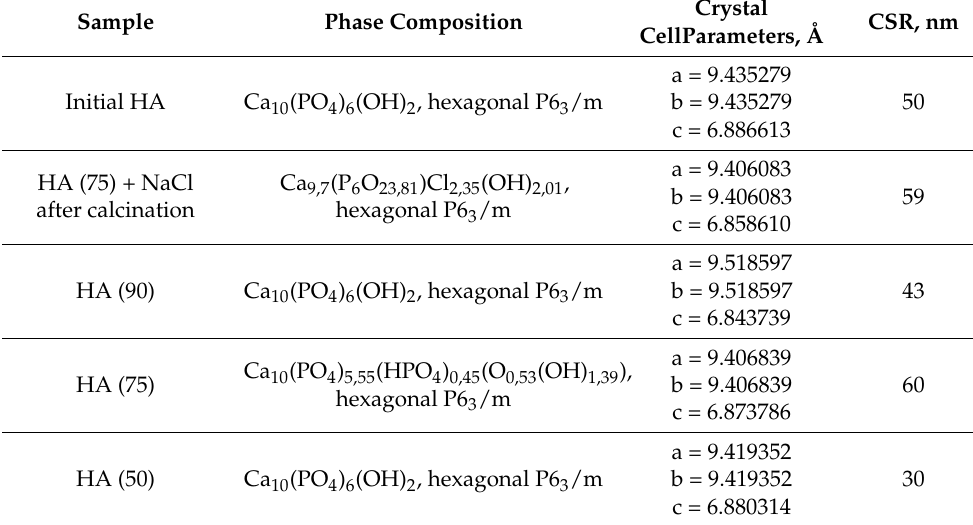
Figure 2. Diffraction patterns of porous frameworks ( a ) HA (90), ( b ) HA (75), ( c ) HA (50). With an increase in the amount of NaCl, the lattice parameters and coherent scattering region (CSR) of the samples change (Table 2). Depending on the amount of NaCl, the phase ratio changes, which leads to a different final structure of the hydroxyapatite framework. Table 2. Crystal parameters HA systems of different compositions.